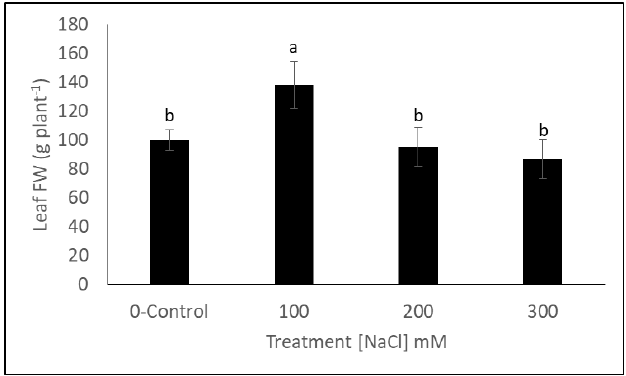
Fig. 1: Leaf fresh weight (FW) in iceplant subjected to different salt con- ditions. Means (n=6) ± SD were compared with Duncan test. Bars followed by a common letter are not significantly different